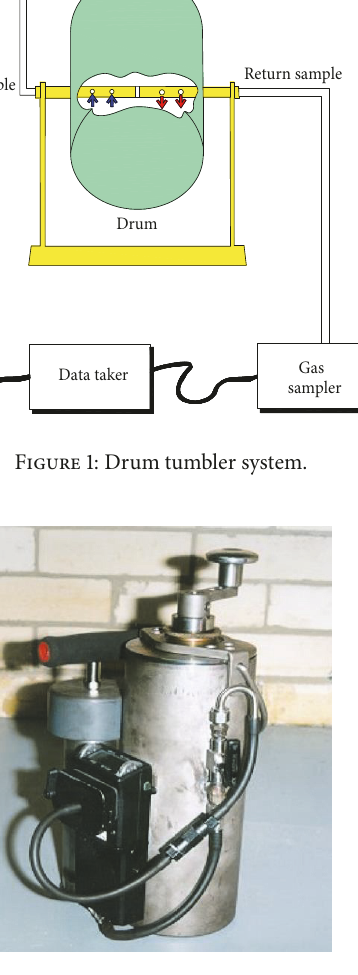
Figure 2: Portable gas